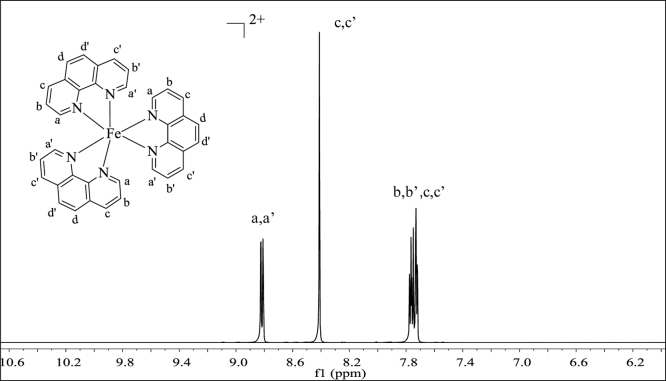
1H NMR spectrum (500 MHz) of complex 2 in dimethylsulfoxide-d6.